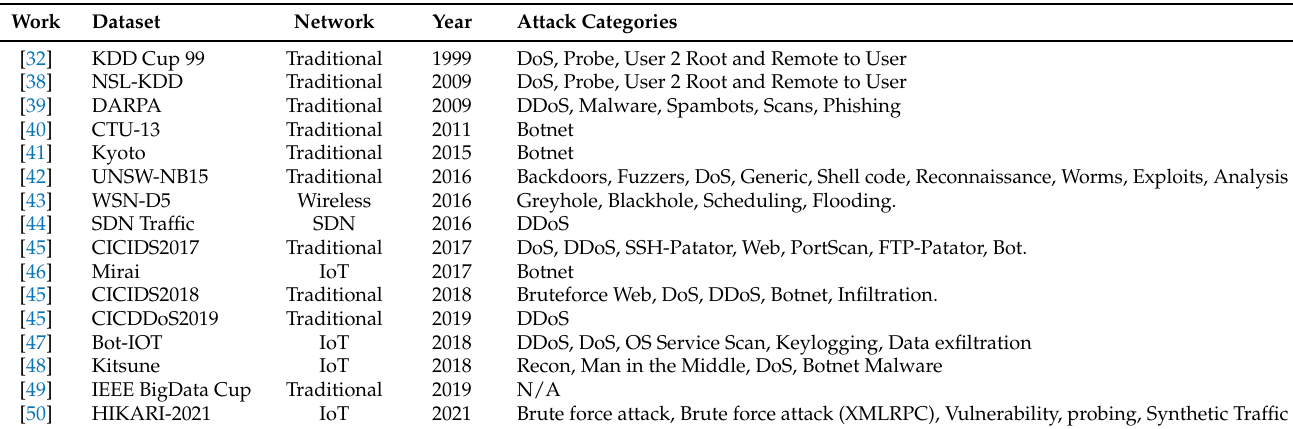
Table 1. Datasets used in the